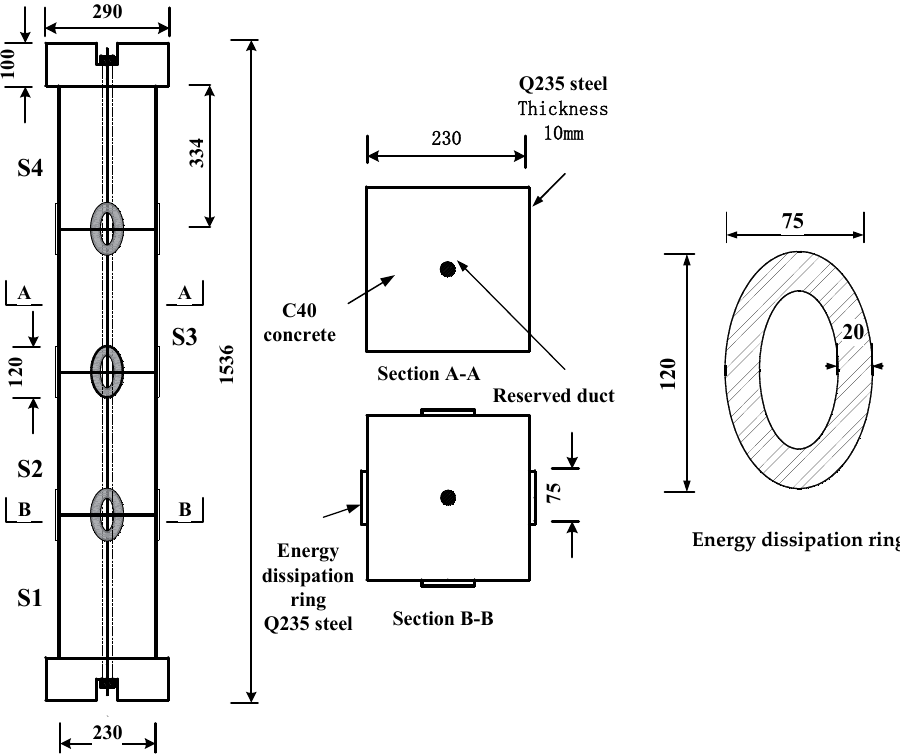
Figure 7. Structure of precast assembled pier test piece (unit: mm).